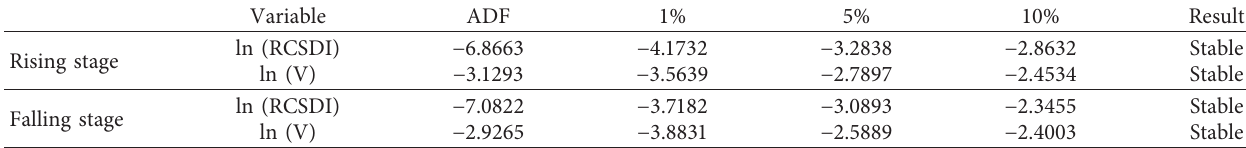
Table 5: ADF test results of rising stage and falling stage.